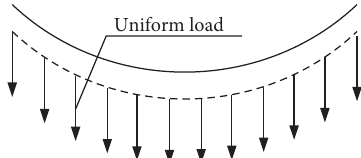
Figure 5: Uniform load on